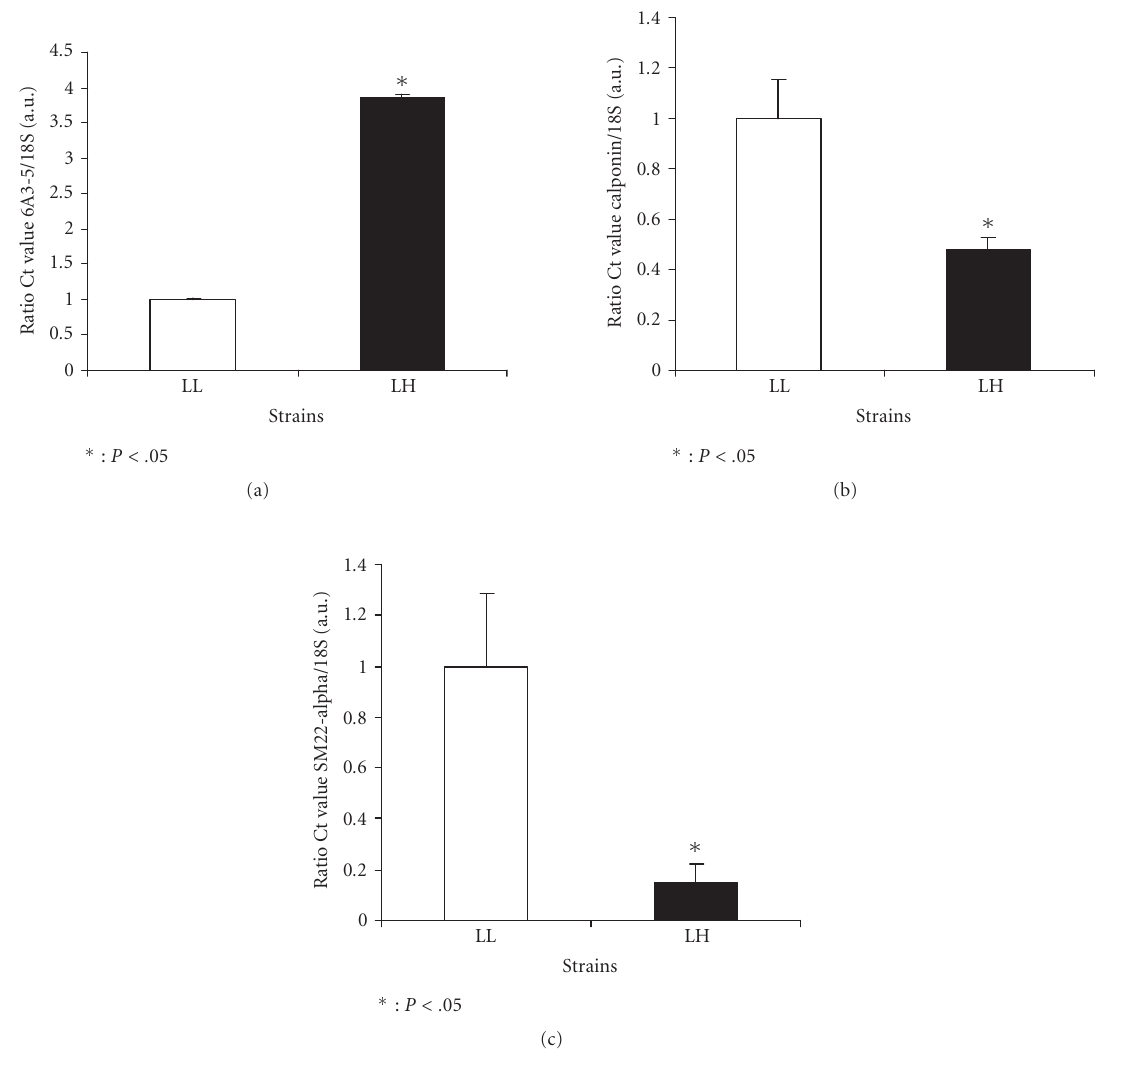
Figure 8: Expression of 6A3-5/Osa2 and vascular phenotype in LH versus LL rats . (a) 6A3-5/Osa2 aortic mRNA expression is significantly higher in hypertensive (LH) compared to normotensive (LL) rats. (b) Calponin (VSMC contractile phenotype marker) aortic mRNA gene expression is significantly reduced in LH versus LL rats. (c) SM22 alpha (VSMC contractile phenotype marker) aortic mRNA gene expression is significantly reduced in LH versus LL rats. Results are indicated as a ratio of mRNA expression in comparison to 18 S expression. Data are presented as means ± SEM . ∗ : P < . 05 versus LL normotensive